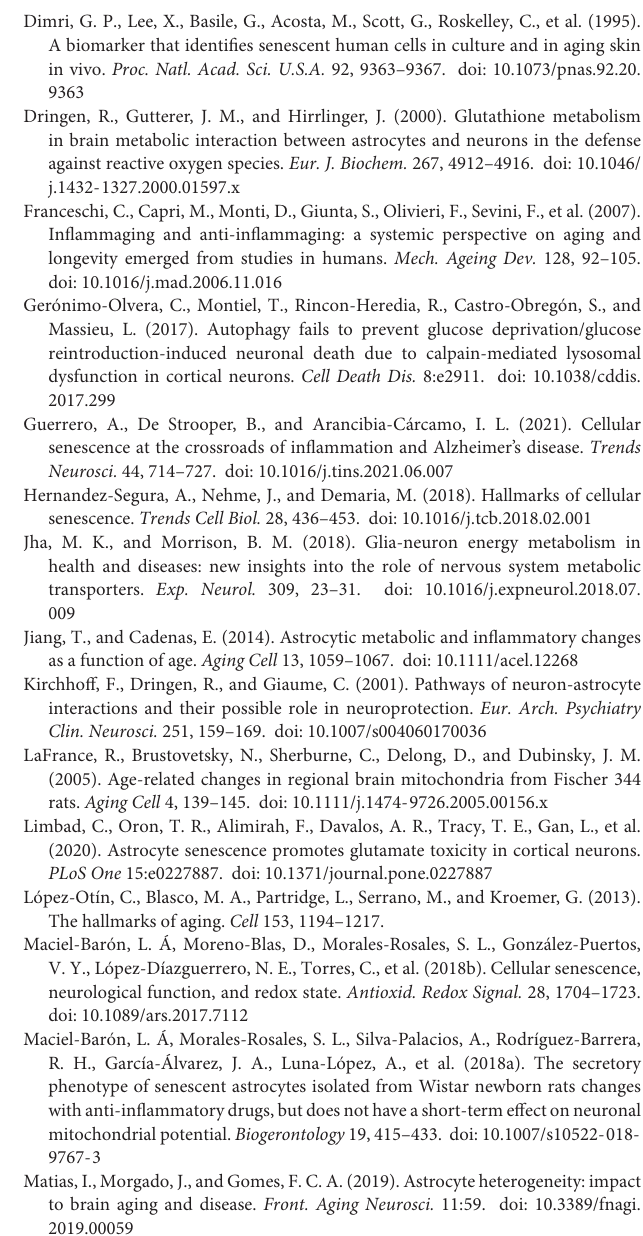
quantification. Each point represents the mean ± SD of three independent experiments. Statistical significance tested by the ANOVA and the Tukey–Kramer test ∗ p ≤ 0.05 with respect to control cells. Supplementary Figure 2 | Mitochondrial morphology was evaluated by fluorescent microscopy by using MitoTracker red as described in the methodology. (A) Representative images of the three basic morphologies used for classification: tubular, fragmented, and intermediate. (B) Representative images observed in neurons, neurons + CA, and neurons + SA. (C) The percentage of evaluated morphologies in each condition. A total of 50 cells were blindly counted per